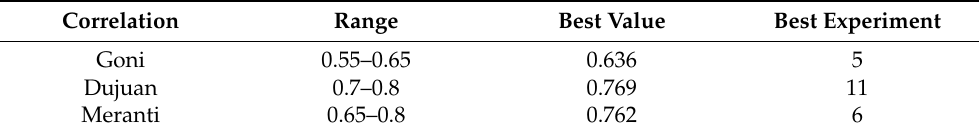
Table 5. R statistics of the wind speed simulation in the three typhoon events.